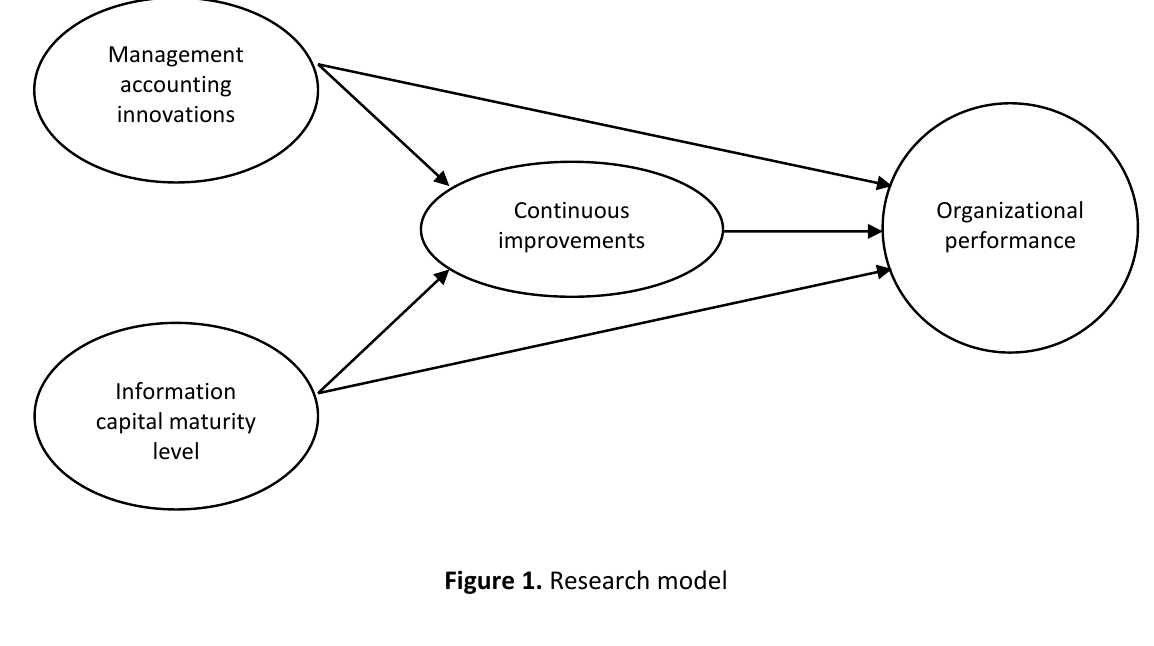
Figure 1. Research